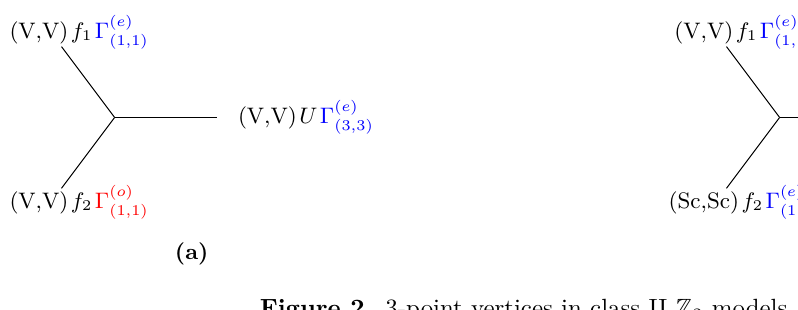
Figure 2. 3-point vertices in class II Z 2